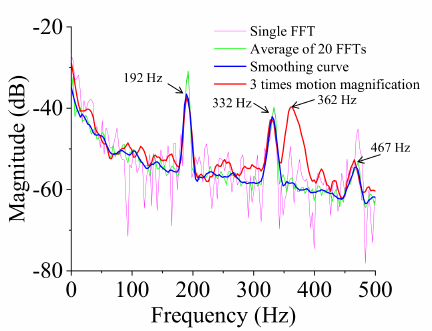
Figure 15. Spectral data of the healthy fully-assembled TPS panel after applying motion magnification.